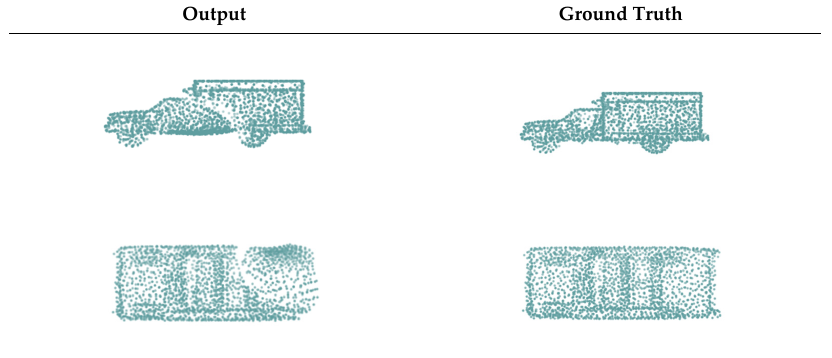
Figure 7. The completion shape of different densities. 5.3. The Effect of the Scale of Occlusion In theory, the more occluded parts, the more difficult it is to extract the features of the point cloud, and the completion effect may be affected to a certain extent. To verify the effect of the volume of the occluded part on network performance, we designed an experiment with 50% occlusion. The experimental results showed that under 50% occlu- sion, the CD of the missing part was 4.112 × 10 − 2 , while the CD of the missing part in Section 4 (25% occlusion) was 4.104 × 10 − 2 . The results showed that as the degree of